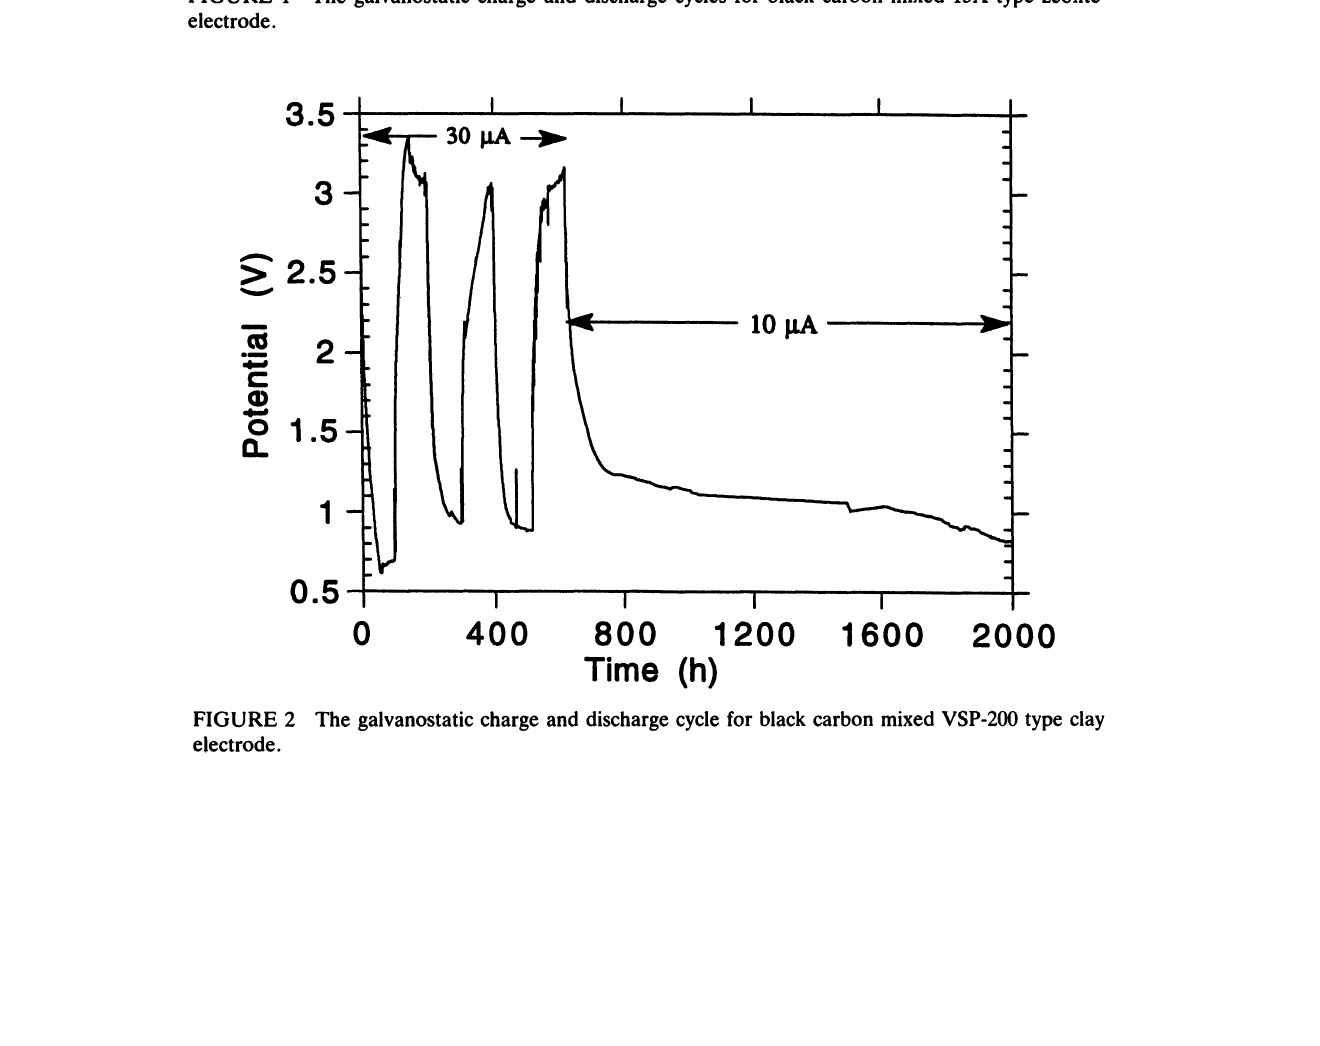
FIGURE The galvanostatic charge and discharge cycles for black carbon mixed 13X type zeolite electrode.